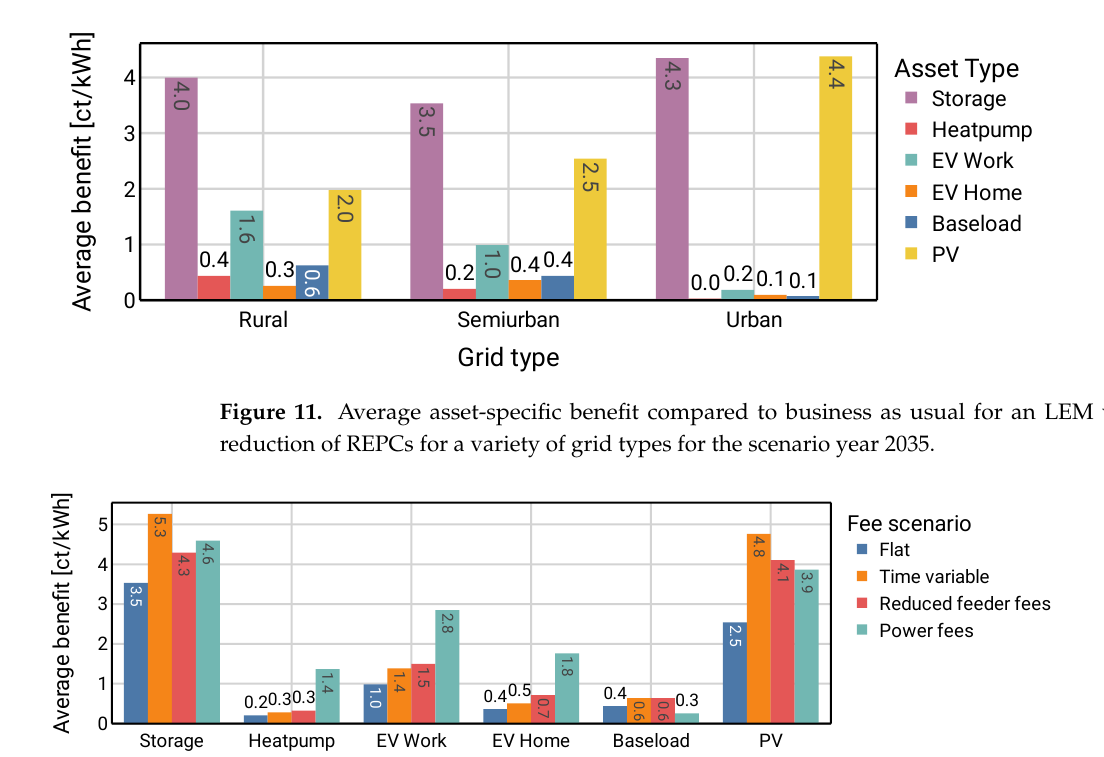
Figure 11. Average asset-specific benefit compared to business as usual for an LEM without a re- duction of REPCs for a variety of grid types for the scenario year 2035.